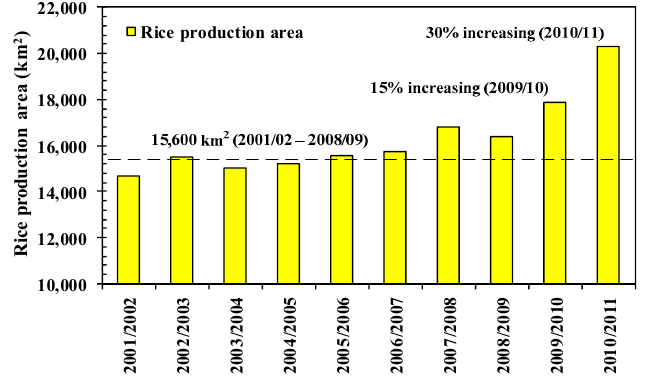
Figure 9. Rice production area in the UCP’s flood-prone area.